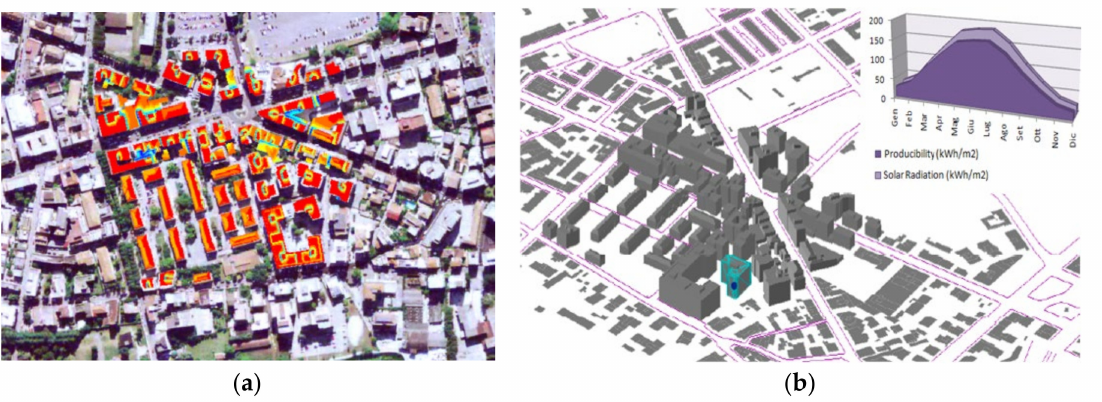
Figure 8. ( a ) Roofs classification of residential units and ( b ) theoretical energy production of individual residential units (kWh / m 2